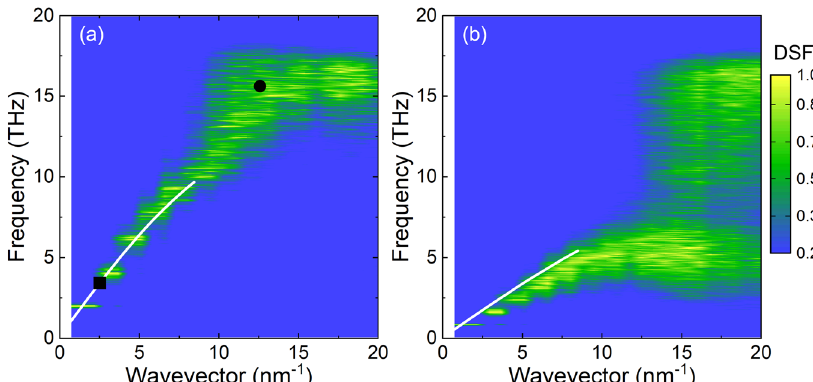
Fig. 1 Dynamical structure factor. The calculated dynamical structure factor (DSF) of amorphous silicon for the longitudinal ( a ) and transverse ( b ) excitations at room-temperature. The calculated amorphous silicon contains 4096 atoms. The solid white lines are, respectively, the phonon dispersion of the longitudinal branch ( a ) and the transverse branch ( b ) for crystal silicon. The dots in ( a ) are the speci fi c vibrations that applied in wave-packet